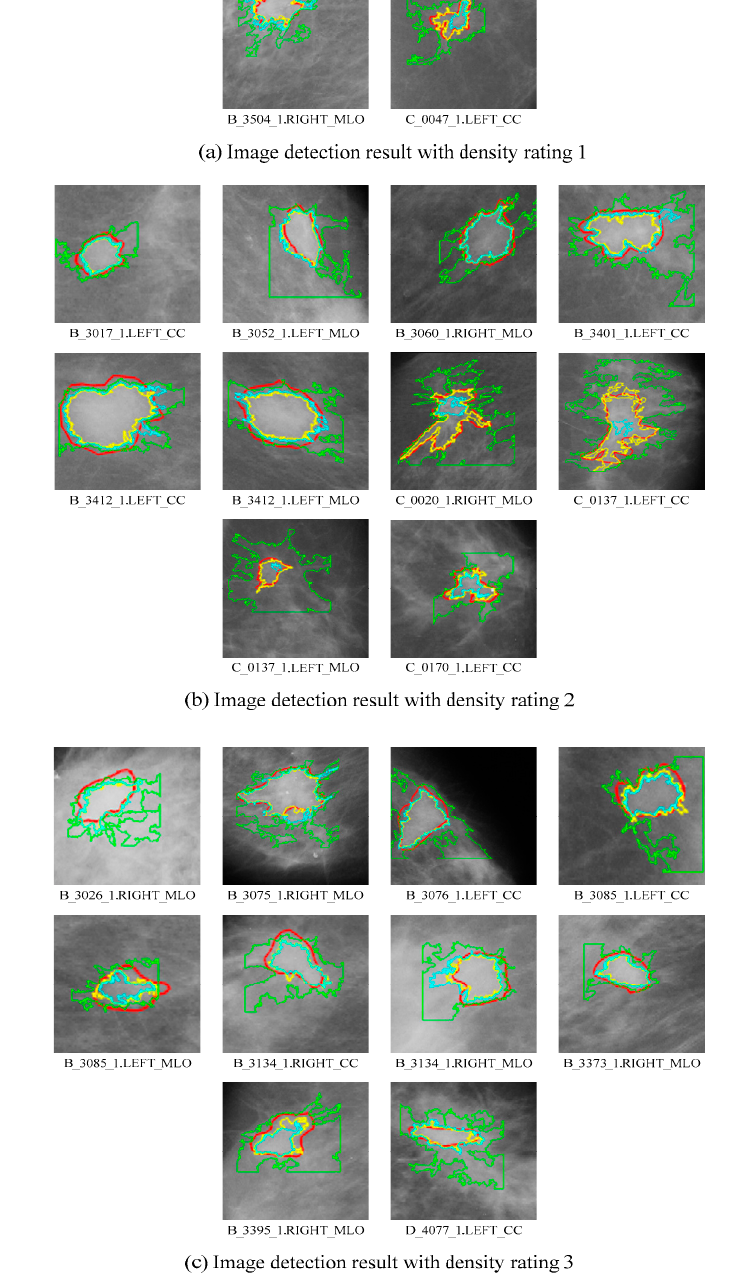
Figure 12. The detection results of different experimental methods.